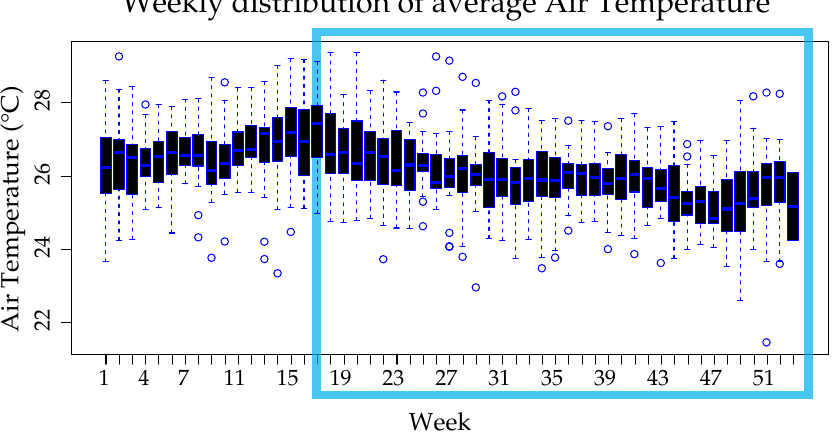
Figure 7. Weekly average air temperature distribution, the weekly average air temperature was grouped by week to visualize changes over the years by week.